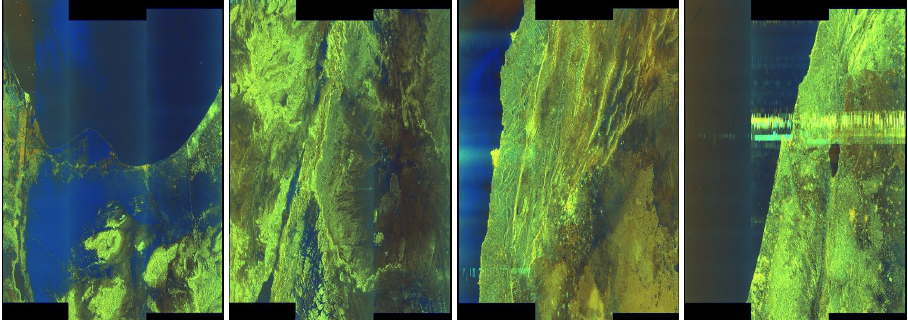
Figure 7. TELAVIV quick-looks—exemplary pictures—first on the left without artifacts, and the subsequent images to the right, with increasing degrees of damage: classes 0, I, II, and III.